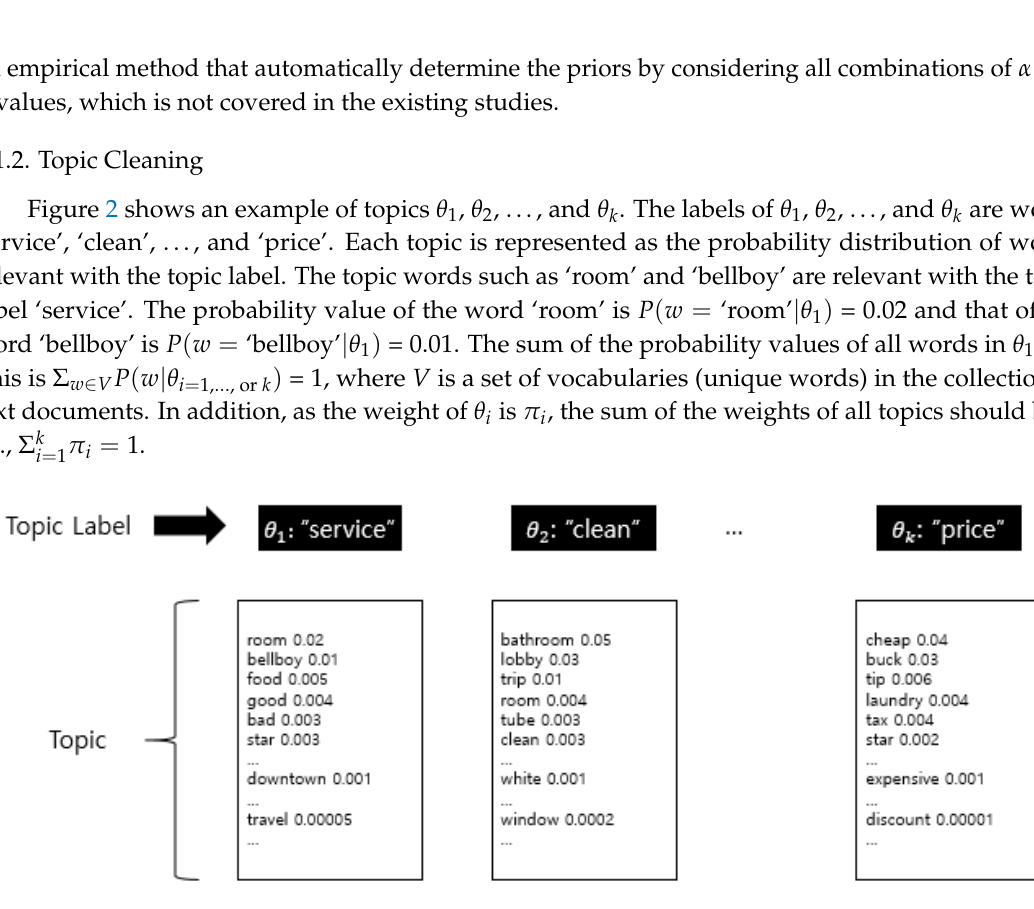
Figure 2. An example of topics through Latent Dirichlet Allocation